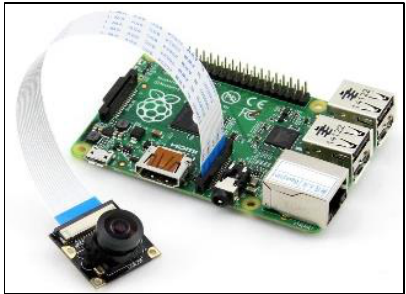
Figure 2. Raspberry Pi with Camera